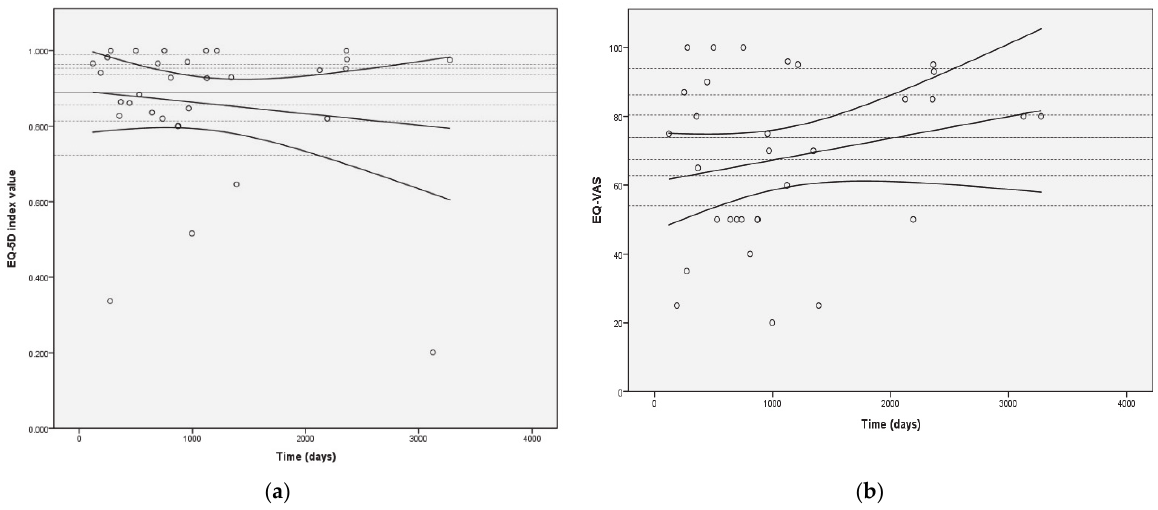
Figure 4. Distribution of EQ ‐ 5D ‐ 5L index values ( a ) and EQ ‐ VAS ( b ) over time of follow ‐ up. Legend: Horizontal dashed lines represent general population EQ ‐ 5D ‐ 5L index values by age groups for Figure 4a and general population EQ ‐ VAS values by age group for Figure 4b (from top to bottom (EQ ‐ 5D ‐ 5L index value/EQ ‐ VAS): 0.963/86.2—age 18–24 years; 0.953/83.9—age 25–34 years; 0.938/80.6—age 35–44 years; 0.898/74.0—age 45–54 years; 0.856/67.4—age 55–64 years; 0.813/62.8— age 65–74 years; and 0.723/54.0—age 75 and older; continuous horizontal line represents general